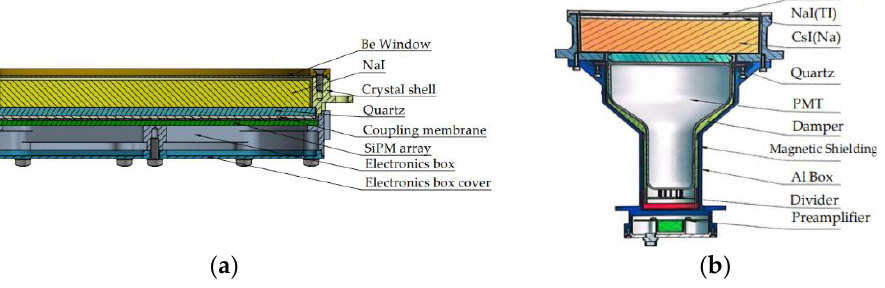
Figure 1. Comparison of the traditional and novel GRM: ( a ) Novel GRM. ( b ) Traditional gamma- ray